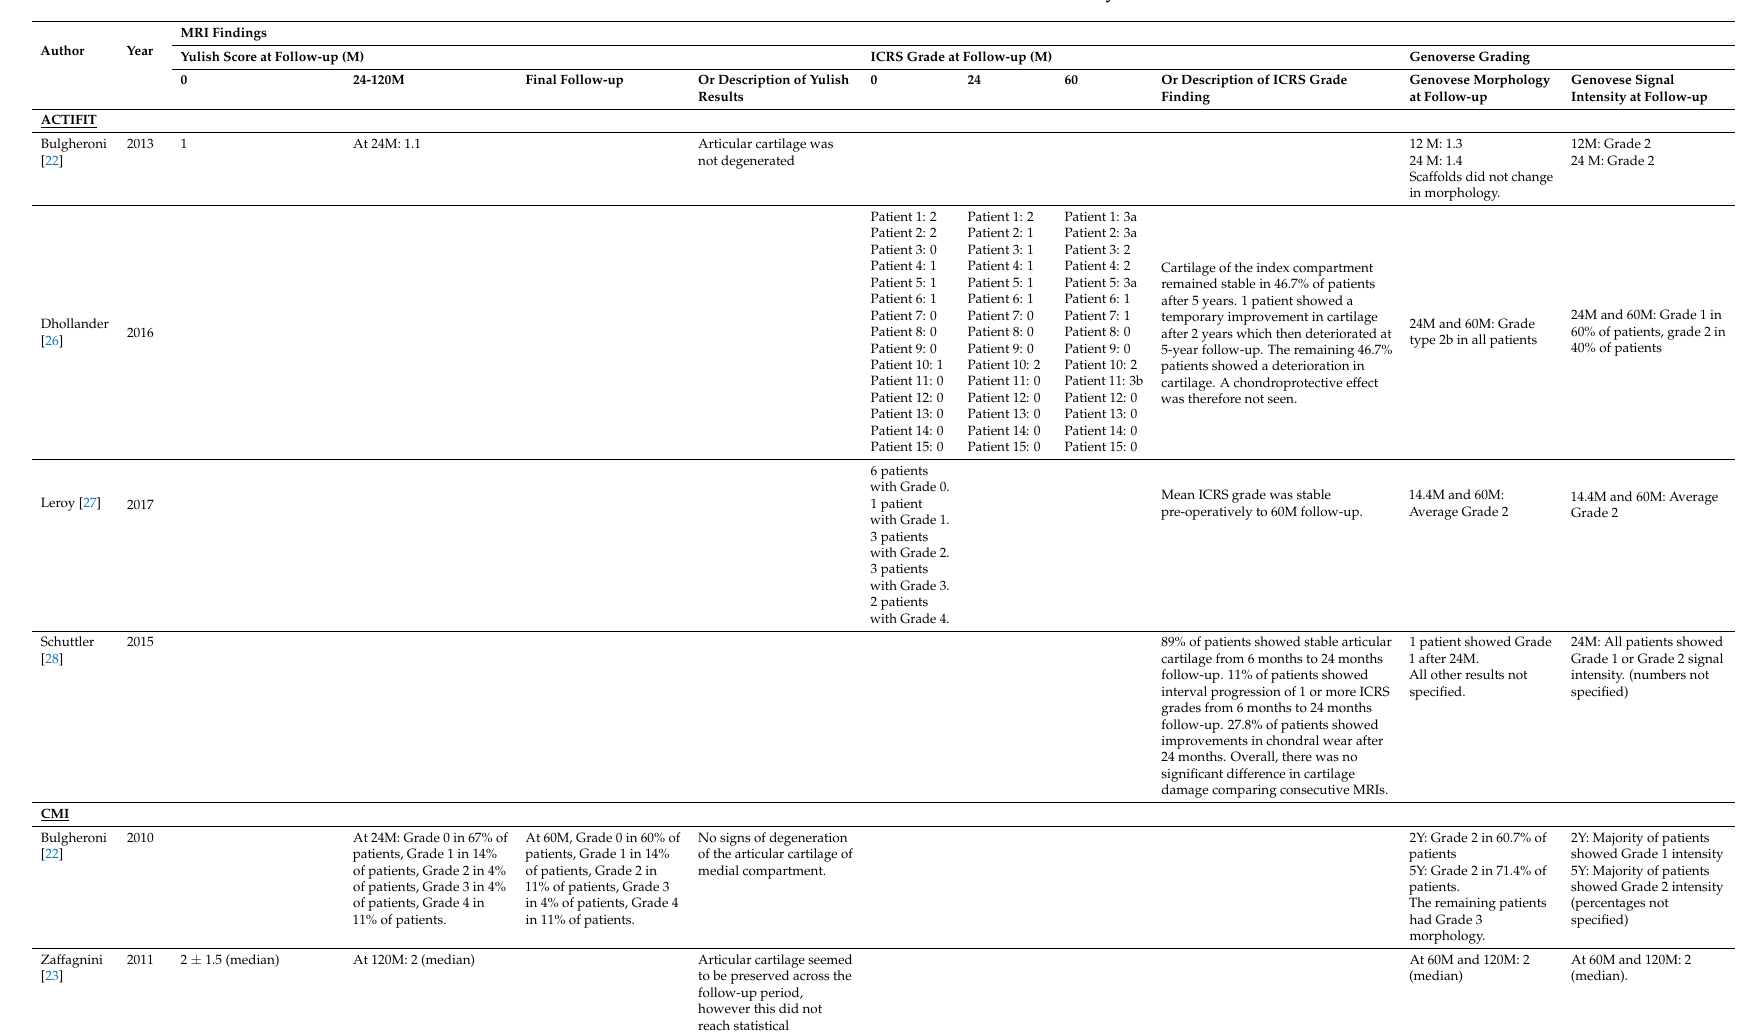
Table 3. The MRI outcome results of each